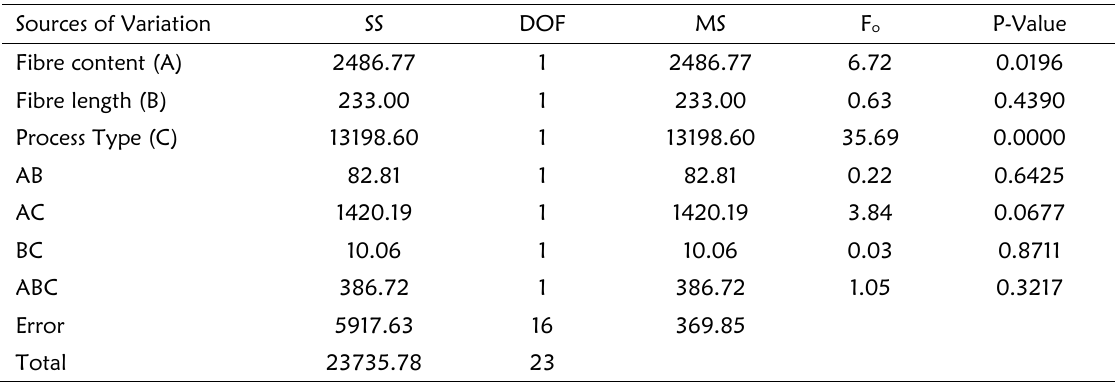
Table 2: Analysis of Variance of Flexural Strength